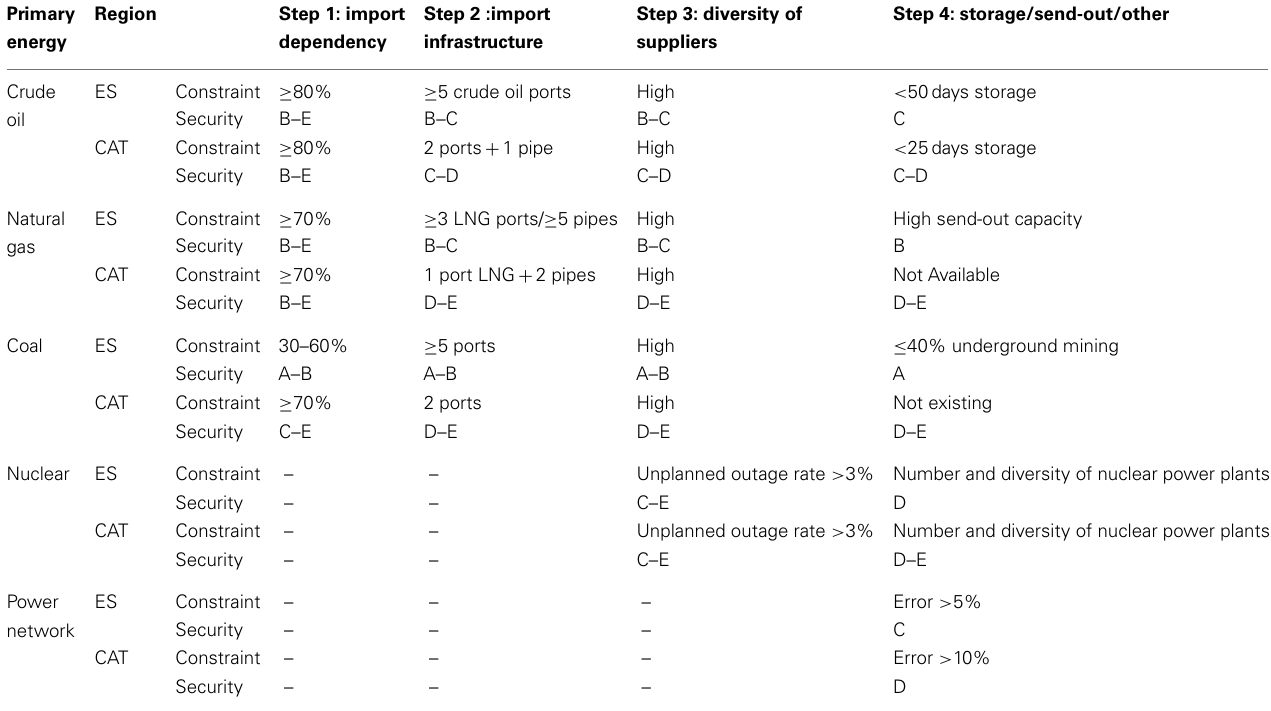
Table 1 | Energy security levels for different primary energy sources in Spain (ES) and Catalonia (CAT), including power network infrastructure, a security level not considered in MOSES procedure .